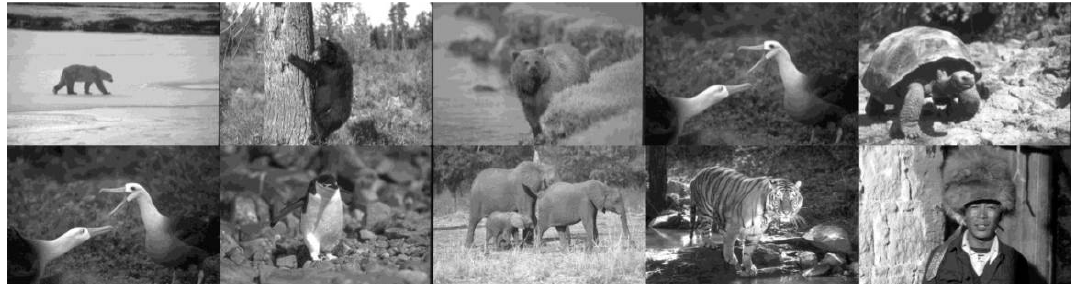
Figure 6. Some representative images in the